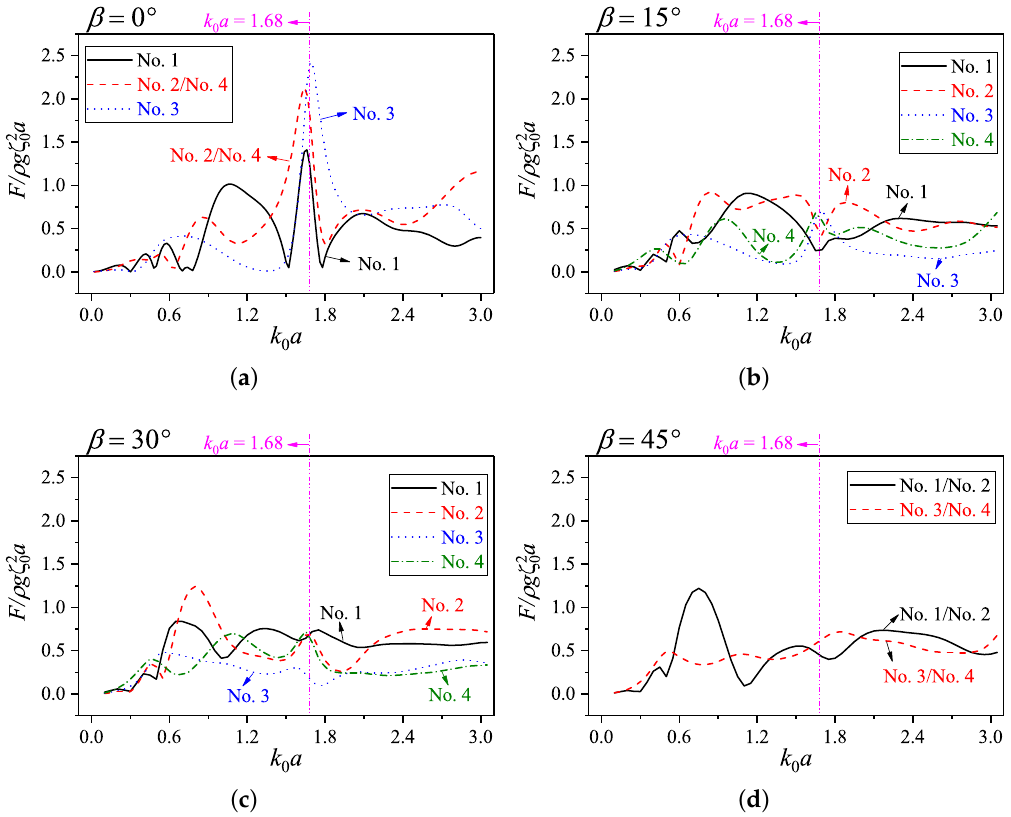
Figure 10. The wave drift forces on each cylinder against four different wave-approach angles: ( a ) β = 0 ◦ , ( b ) β = 15 ◦ , ( c ) β = 30 ◦ , ( d ) β = 45 ◦ .